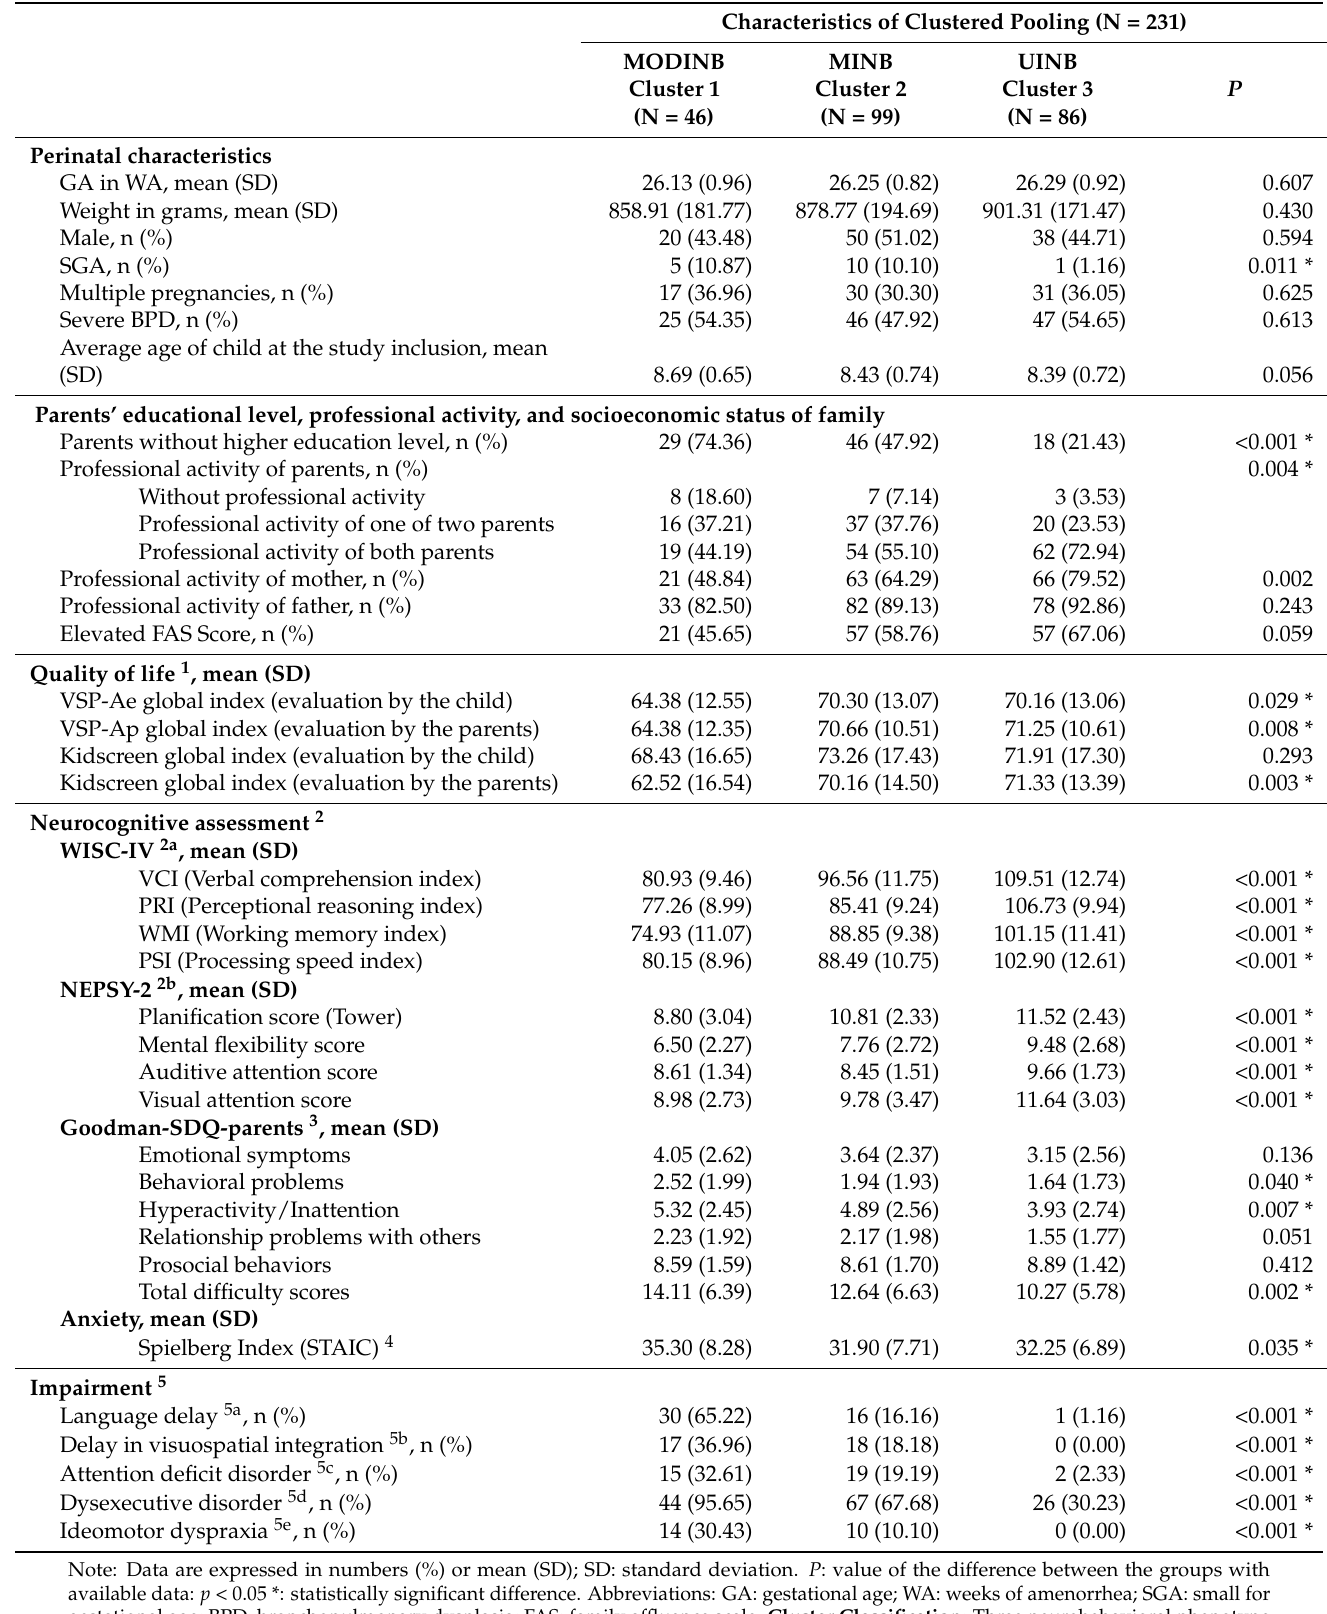
Table 1. Characteristics of the clustered pooling